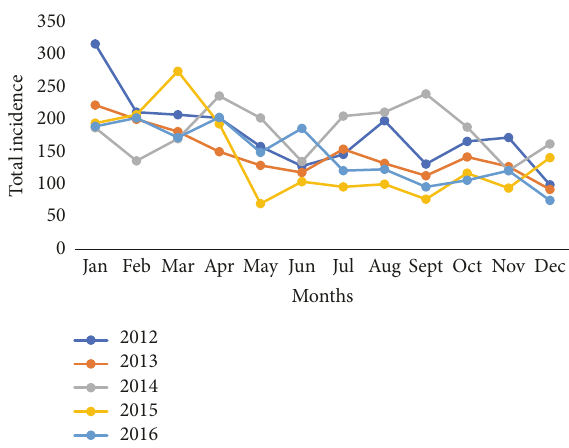
Figure 5: Yearly monthly patterns of diarrhea incidence among children under-five in Jasikan District from 2012 to 2016.